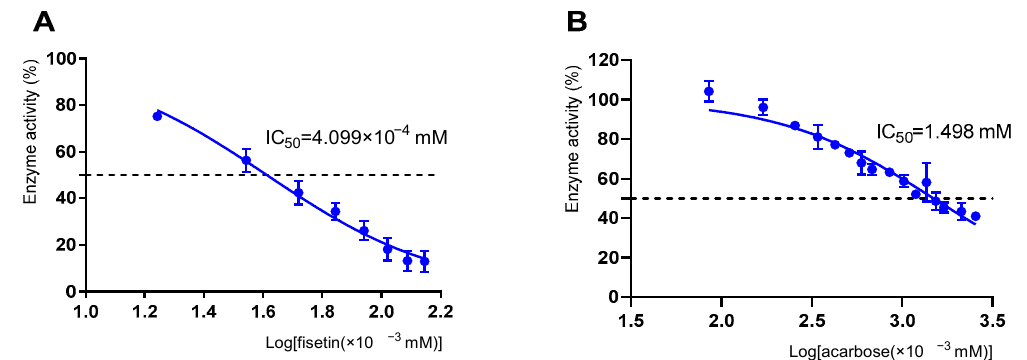
Figure 2. α -glucosidase inhibitor assay. ( A ) Inhibitory activity of fisetin against α -glucosidase. ( B ) Inhibitory activity of Figure 2. α‐ glucosidase inhibitor assay. ( A ) Inhibitory activity of fisetin against α‐ glucosidase. ( B ) Inhibitory activity of acarbose against α acarbose against α‐ glucosidase.